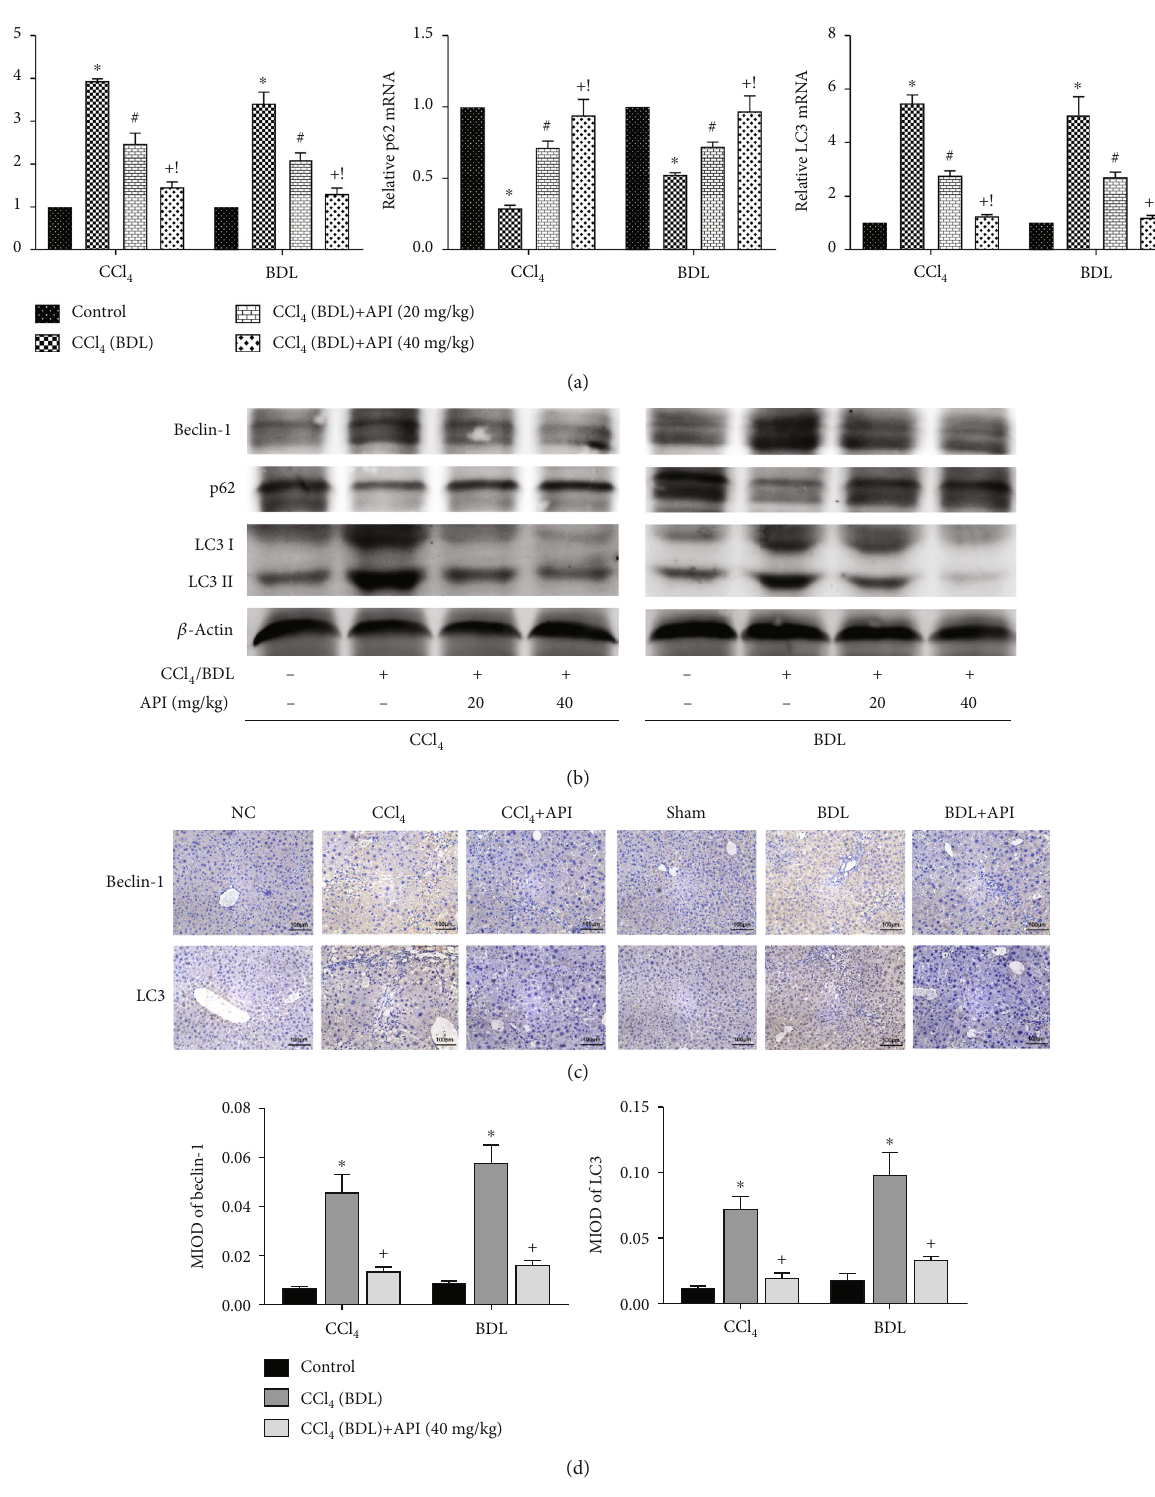
Figure 4: Apigenin alleviated autophagy during liver fi brosis. Notes: (a) relative Beclin-1, p62, and LC3 mRNA levels were determined by qRT-PCR. (b) Western blot analysis of Beclin-1, p62, and LC3. (c) Beclin-1 and LC3 protein expressions in liver tissues are shown by immunohistochemical staining (200x). (d) Final evaluations were made using Image-Pro Plus 6.0 software to calculate the MIOD of the positive staining area. Data are presented as mean ± SD ( n = 6 ; ∗ P < 0 : 05 for CCl (BDL) group vs. control group; # P < 0 : 05 for CCl 4 4 (BDL)+apigenin (20 mg/kg) group vs. CCl (BDL) group; + P < 0 : 05 for CCl (BDL)+apigenin (40 mg/kg) group vs. CCl (BDL) group; 4 4 4 ! P < 0 : 05 for CCl (BDL)+apigenin (40 mg/kg) group vs. CCl (BDL)+apigenin (20 mg/kg) group). Abbreviation: MIOD: mean of integrate 4 4 optical